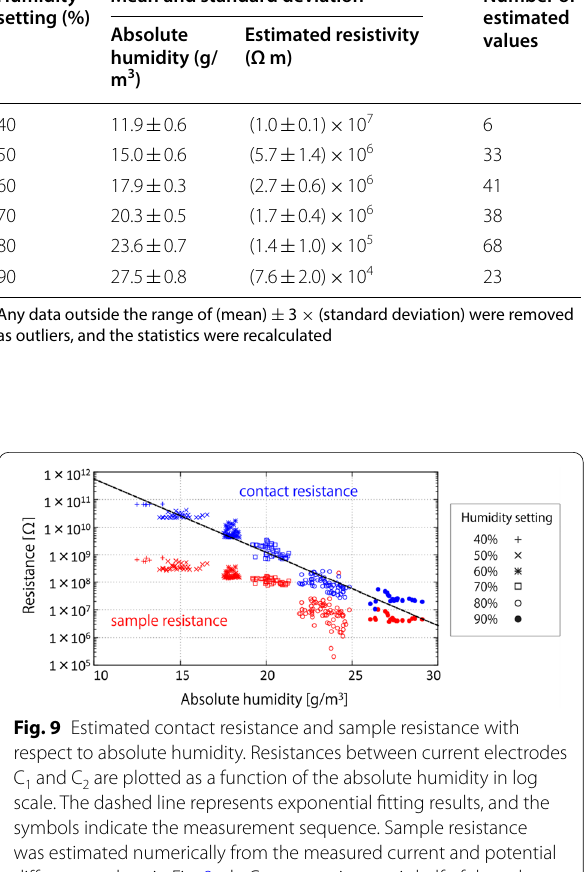
Table 5 Statistical comparison of estimated resistivity in repeated measurements Humidity Mean and standard deviation setting (%)